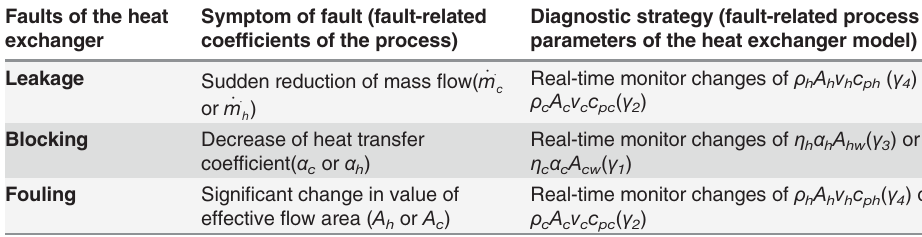
Table 1. Faults of heat